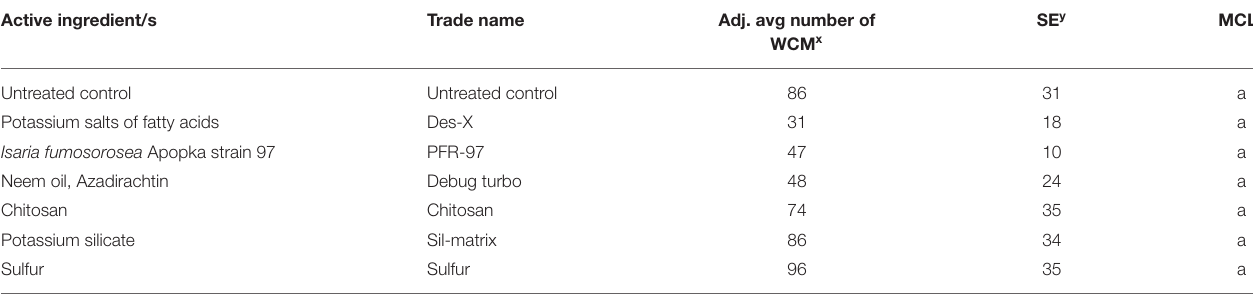
TABLE 4 | Effect of organic pesticide treatments on average WCM total per plant. Active ingredient/s